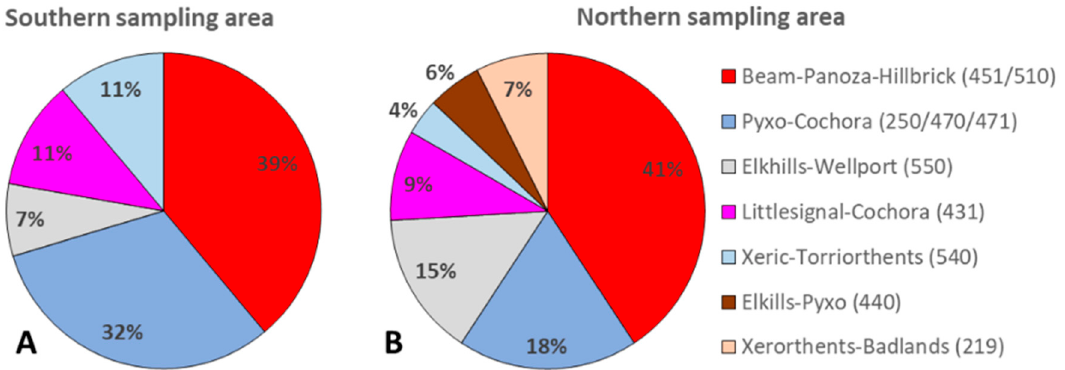
Figure 2. Percentage of soil samples collected from different dominant soil types in the southern ( A ) and northern ( B ) sampling area of the Temblor SRMA between 2018 and 2021 (excluded are soil types that were only sampled occasionally [n = 8]) (overall: n = 106).